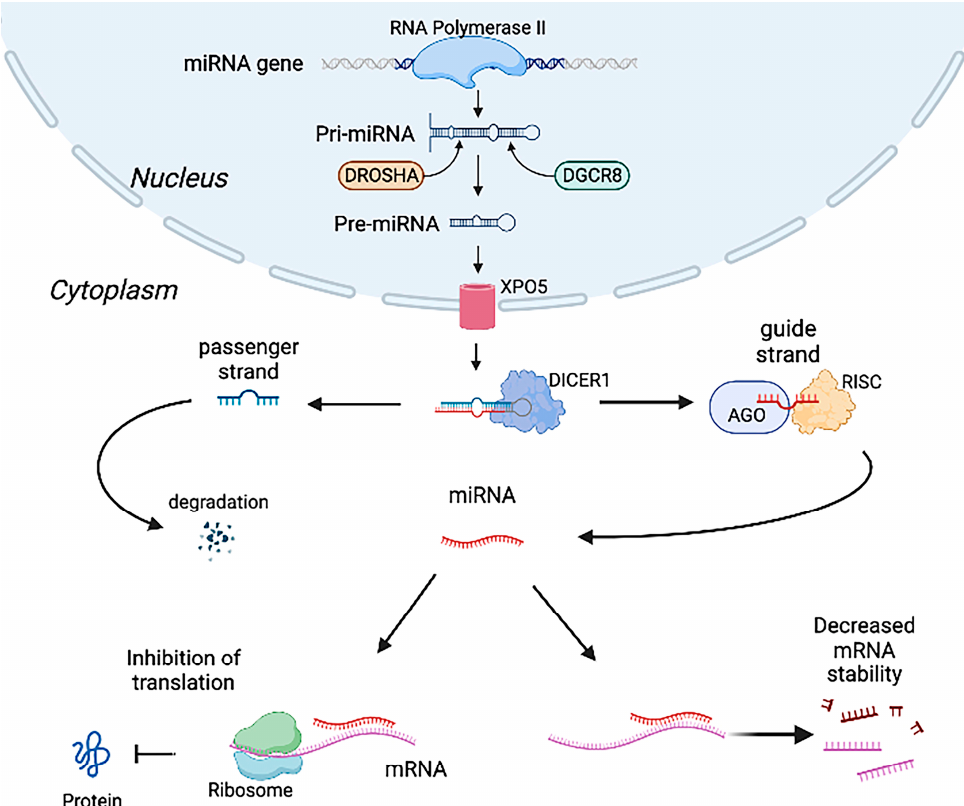
Figure 1. MicroRNA (miRNA) biogenesis and actions. In the nucleus, miRNA is transcribed into the hairpin primary miRNA molecule (pri-miRNA) by RNA polymerase Ⅱ . Pri-miRNA is processed into the precursor miRNA molecule (pre-miRNA) by DROSHA ribonuclease Ⅲ (DROSHA) and DiGeorge syndrome chromosomal 8 (DGCR8). Pre-miRNA is transported to the cytoplasm via nucleocytoplasmic protein exportin-5 (XPO5). Pre-miRNA is then cut into 2 of 21–22 nucleotides by an endoribonuclease DICER (DICER1). Although one of the nucleotides (passenger strand) usually undergoes degradation, the other one (guide strand) is incorporated with argonaute (AGO) and RNA-induced silencing complex (RISC) and becomes a mature miRNA. A mature miRNA a tt enuates protein translation or decreases mRNA stability after binding to target mRNAs.